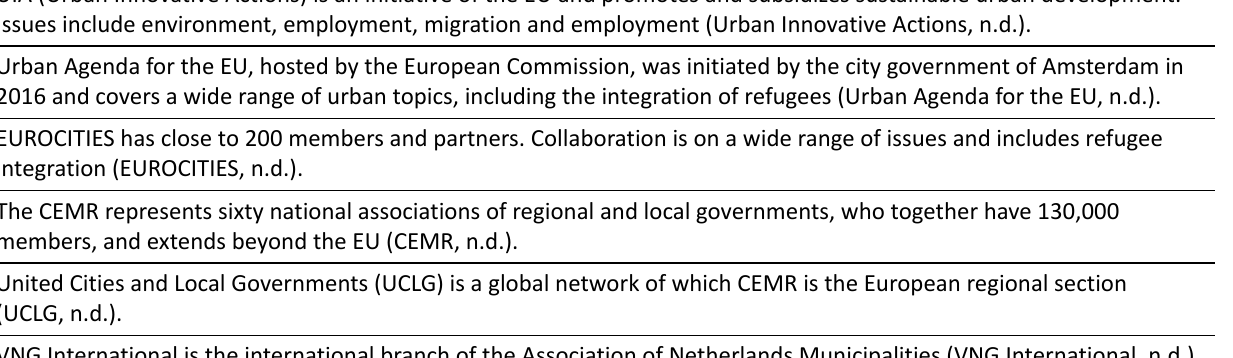
Table 1. List of reviewed city networks. UIA (Urban Innovative Actions) is an initiative of the EU and promotes and subsidizes sustainable urban development. Issues include environment, employment, migration and employment (Urban Innovative Actions, n.d.). Urban Agenda for the EU, hosted by the European Commission, was initiated by the city government of Amsterdam in 2016 and covers a wide range of urban topics, including the integration of refugees (Urban Agenda for the EU, n.d.). EUROCITIES has close to 200 members and partners. Collaboration is on a wide range of issues and includes refugee integration (EUROCITIES, n.d.). The CEMR represents sixty national associations of regional and local governments, who together have 130,000 members, and extends beyond the EU (CEMR, n.d.). United Cities and Local Governments (UCLG) is a global network of which CEMR is the European regional section (UCLG,